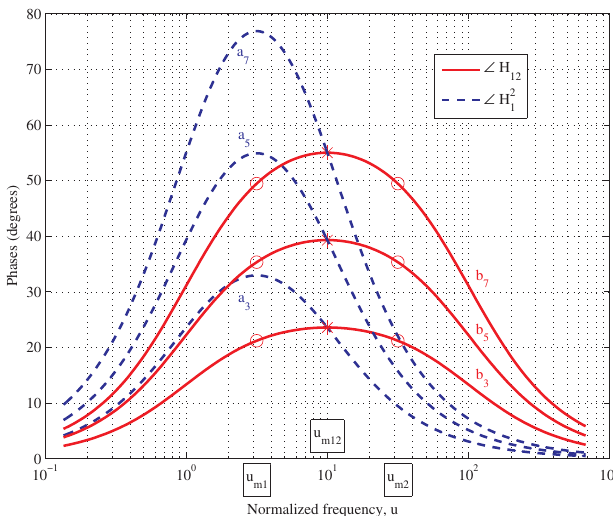
Figure 6. Bode phase diagrams of H 2 (dashed lines) and of the CS-FLEC H 12 (solid lines) for 1 ν = ν 1 = ν 2 = 0.3 (curves a 3 , b 3 ), 0.5 (curves a 5 , b 5 ), 0.7 (curves a 7 , b 7